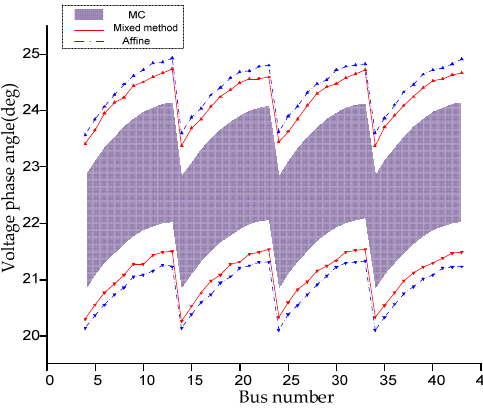
Figure 6. The voltage phase angle intervals of the PV power generation unit.